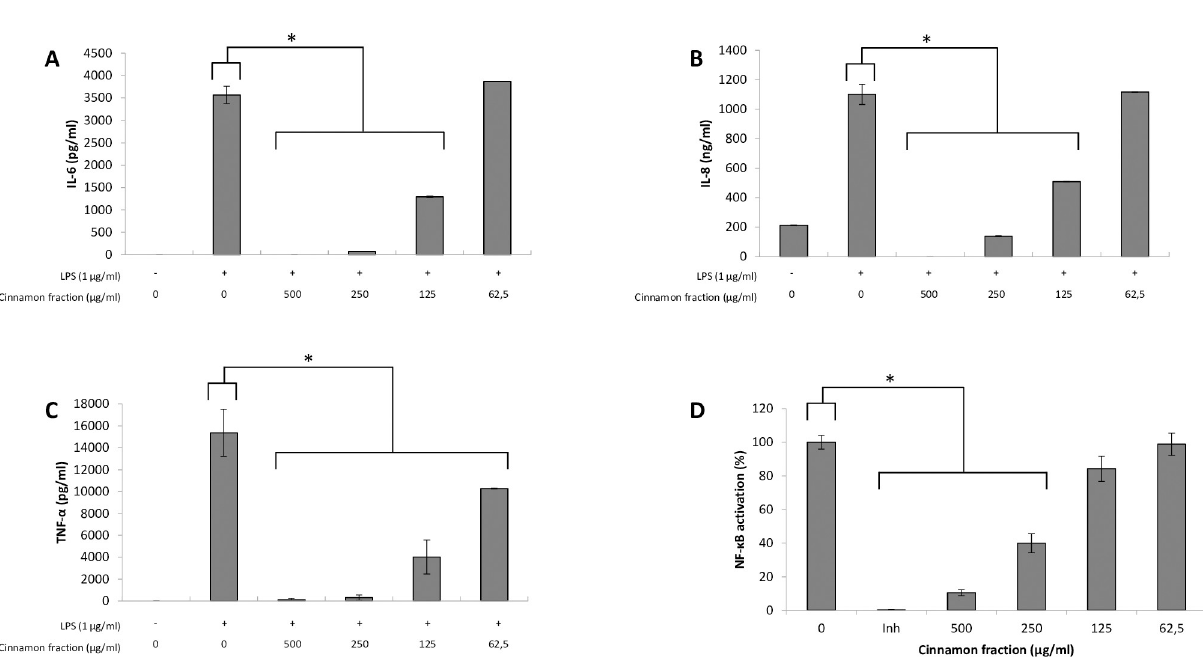
Fig 2. Effect of the cinnamon fraction on IL-6 (panel A), IL-8 (panel B), and TNF- α (panel C) secretion by macrophages and on NF- κ B activation in monocytes stimulated with E . coli LPS. Assays were performed in triplicate in two independent experiments and the means ± SD were calculated. � , significant inhibition at p <